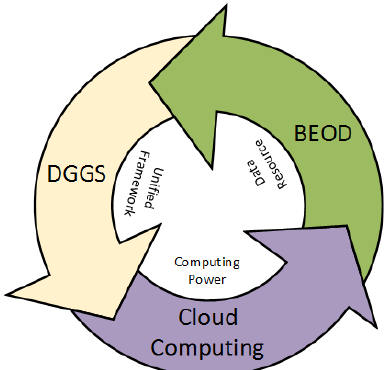
Figure 1. The trinity of big Earth observation data, cloud computing and discrete global grid systems.